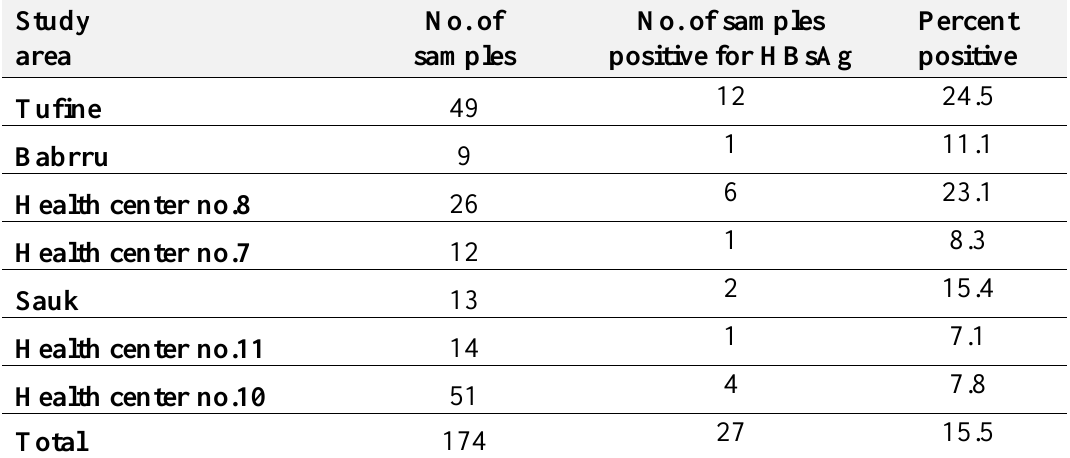
Table 3. Distribution of HBV cases by areas